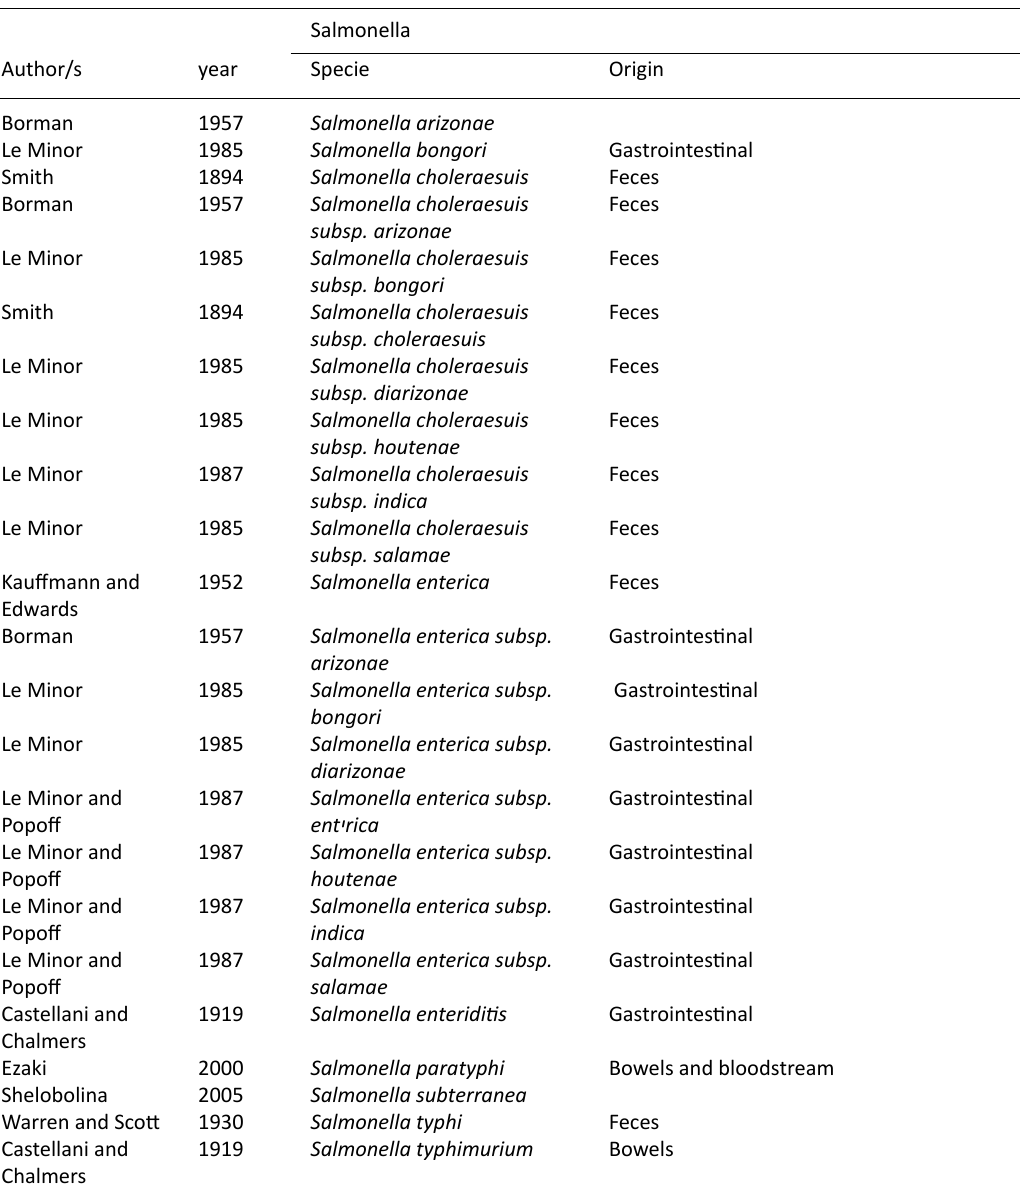
Table 1. Taxonomic classification of the Salmonella genus Salmonella